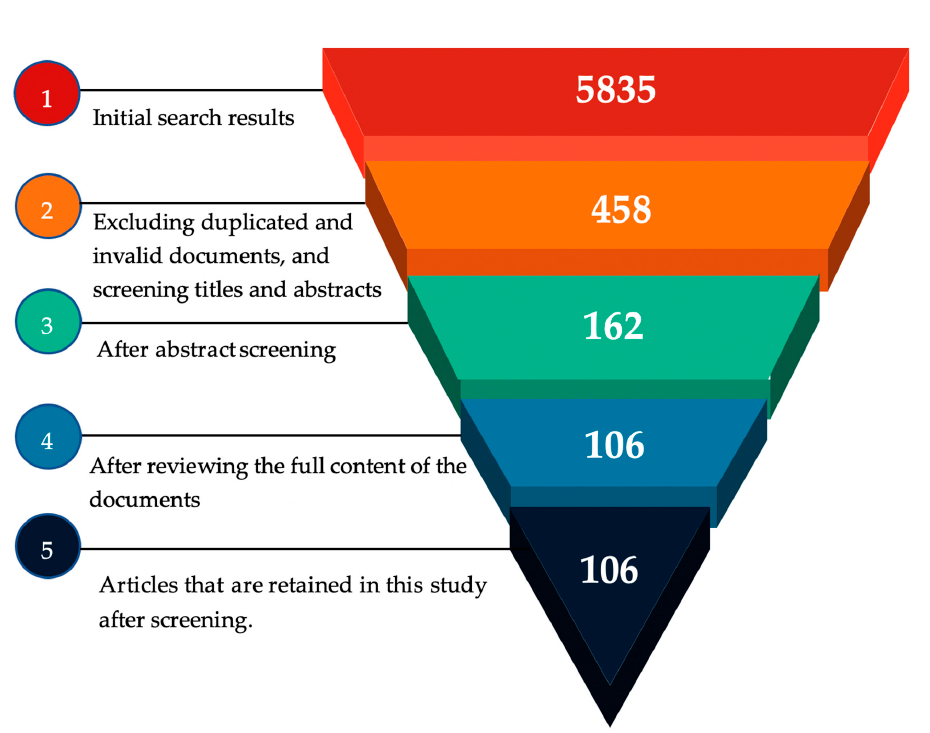
Figure 2. Article Screening Process in This